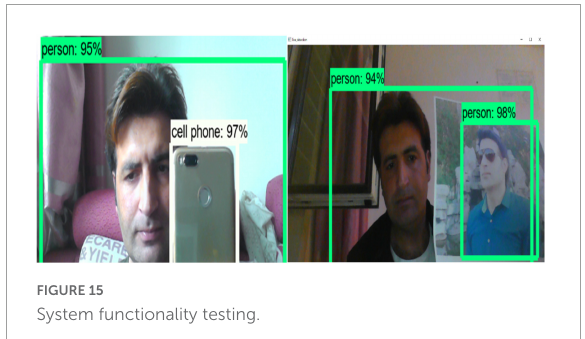
FIGURE15 System functionality testing.